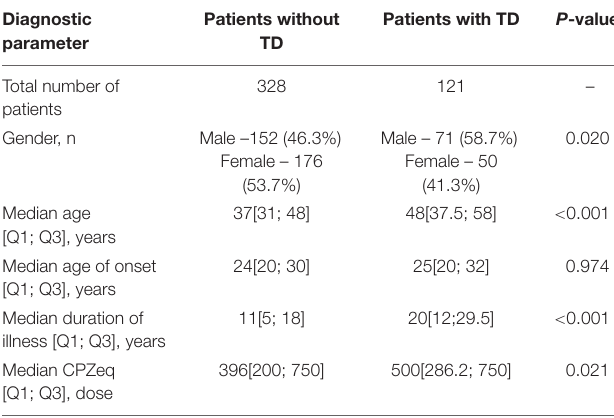
TABLE 1 | Main demographic and clinical parameters of studied